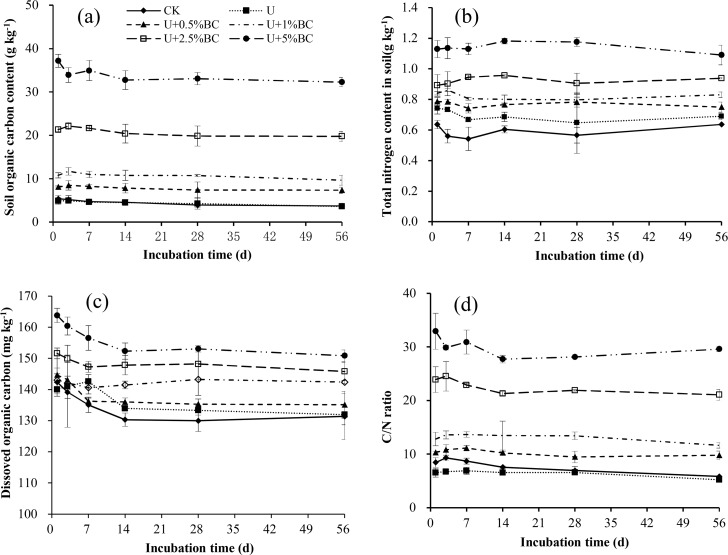
Dynamic variation of the contents of soil organic carbon (a), soil total nitrogen (b), dissolved organic carbon (c), and (d) C/N ratio in different treatments over a 56-day incubation. Vertical bars in the figures represent standard error of the means (n = 3).